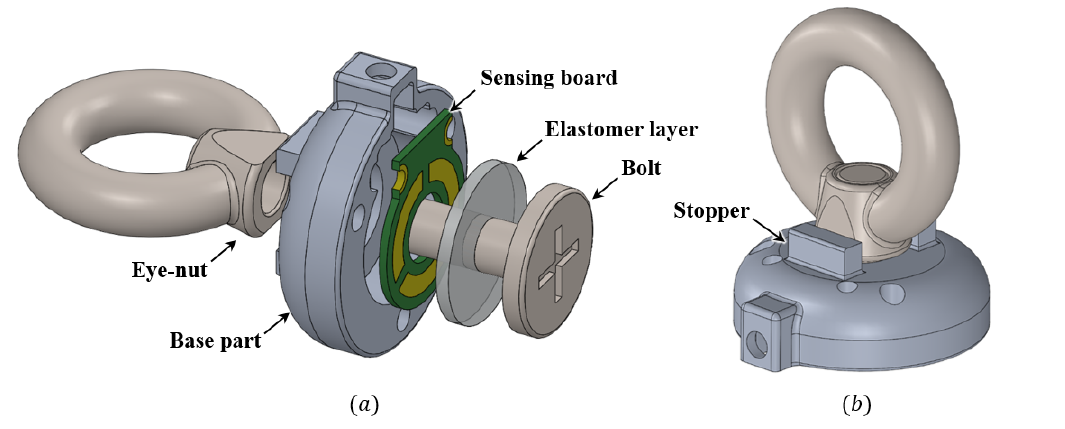
Figure 1. Structure of the proposed sensor. ( a ) Exploded view of the proposed sensor. ( b ) Prototype of the proposed